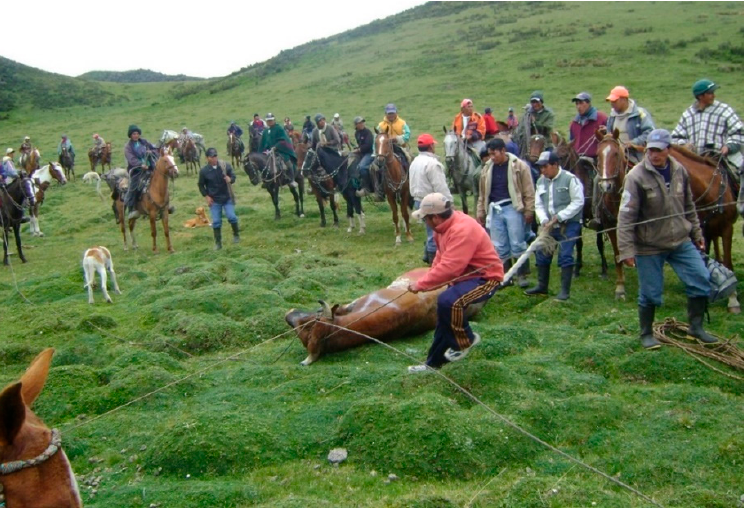
Figure 4. Roundup and counting of cattle as a conservation páramo community management prac-